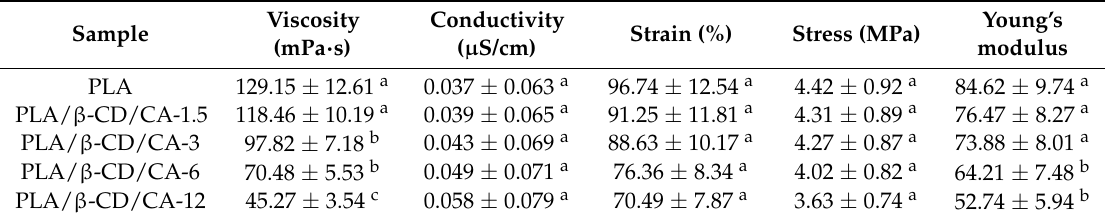
Table 1. The physical characteristics of different fibers.